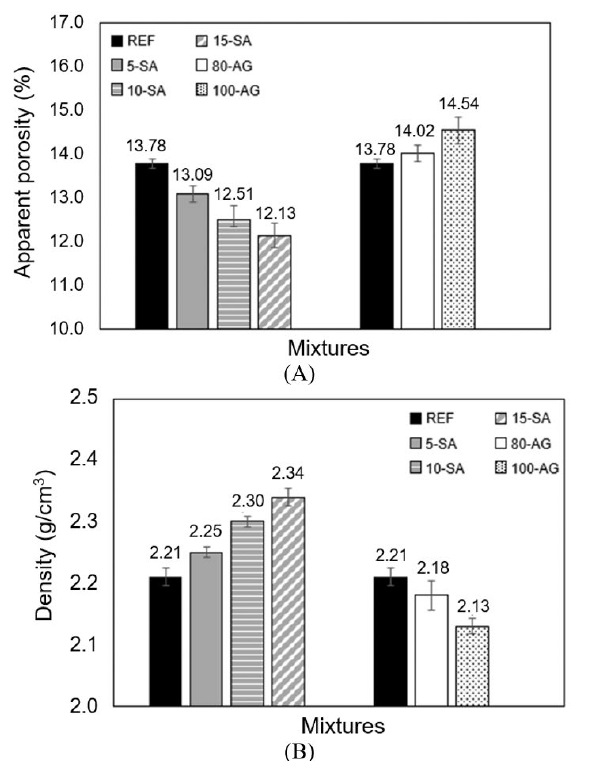
Figure 7. (A) Apparent porosity and (B) density of concretes with different silica fume and mortar contents.